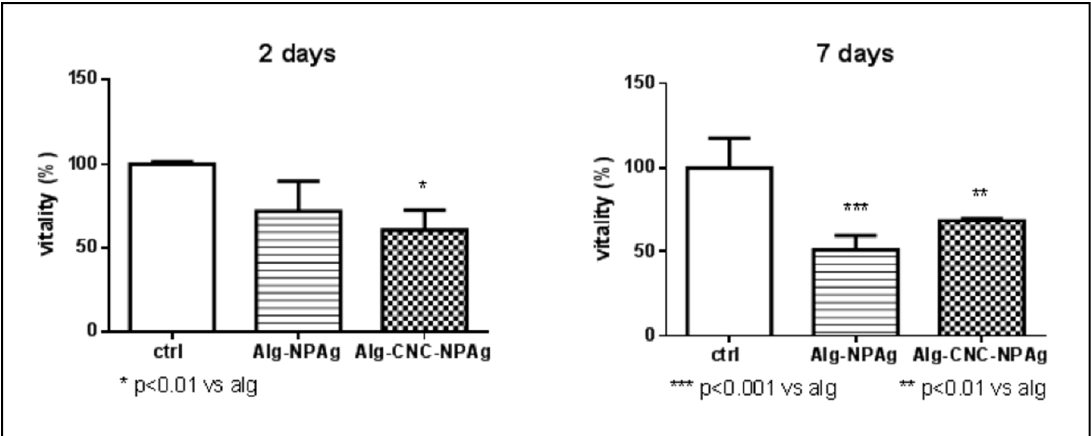
Figure 6. Cell viability % of HepG2 cells NOT TREATED (ctrl), TREATED with ALG (5% w/v )-AgNP (250 ppm) and ALG/CNC (5% and 3% w/v ) + AgNP (250 ppm) scaffolds.